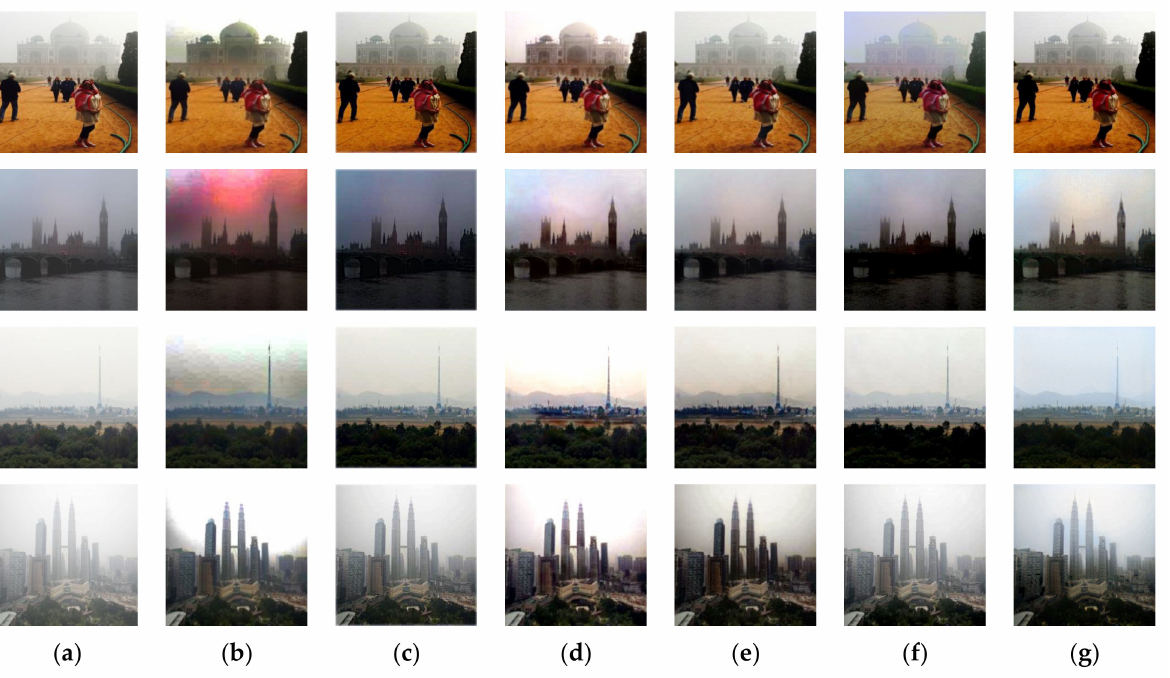
Figure 10. Visual results on real-world images: ( a ) hazy images; ( b ) DCP; ( c ) AOD-Net; ( d ) GCANet; ( e ) EPDN; ( f ) YOLY; ( g ) proposed